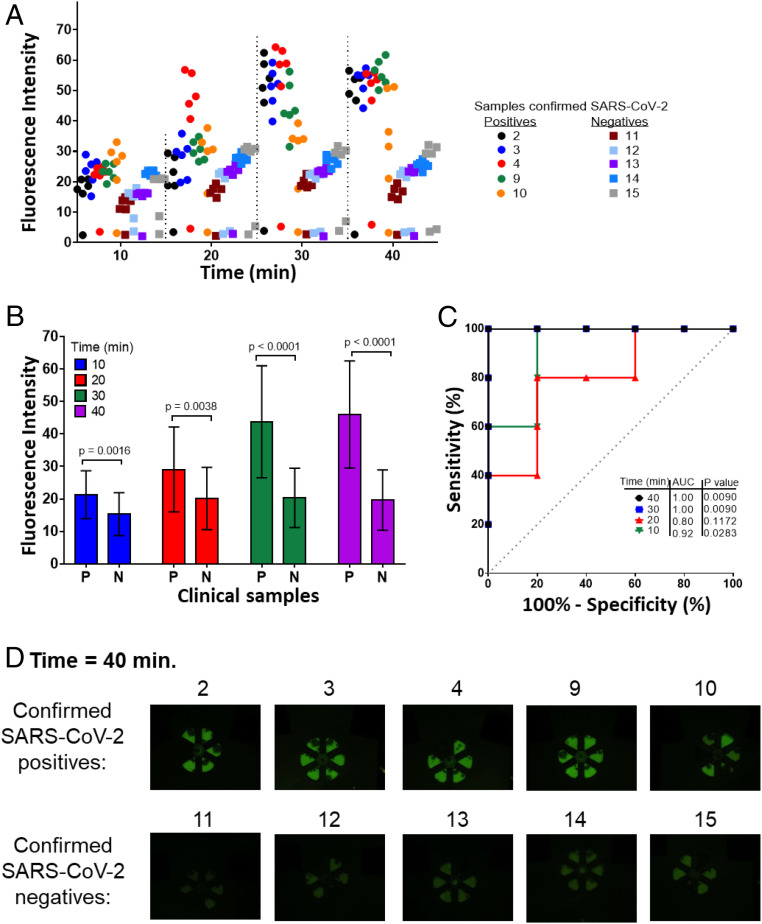
Rapid detection of SARS-CoV-2 in VTM clinical samples using an additively manufactured microfluidic cartridge and handheld POC instrument. (A) Fluorescence intensities of real-time RT-LAMP on the additively manufactured amplification chip at different time points. The developed device can clearly differentiate all of the positives samples from the negatives as fast as in 30 min (n = 6). (B) A t test shows that the fluorescence intensity of the positive samples (P) is statistically significant in comparison with the negative samples (N). (C) ROC curves analyzed for the four time conditions. For each time point, the positive samples were analyzed against the negative samples. (D) Fluorescence images of real-time RT-LAMP SARS-CoV-2 analysis at the endpoint of detection on the additively manufactured amplification chip.